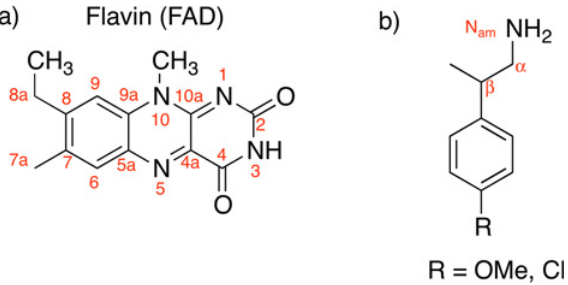
Fig 2. Structure and nomenclature. a) isoalloxazine ring of FAD. b) p-CMP or p-MMP.